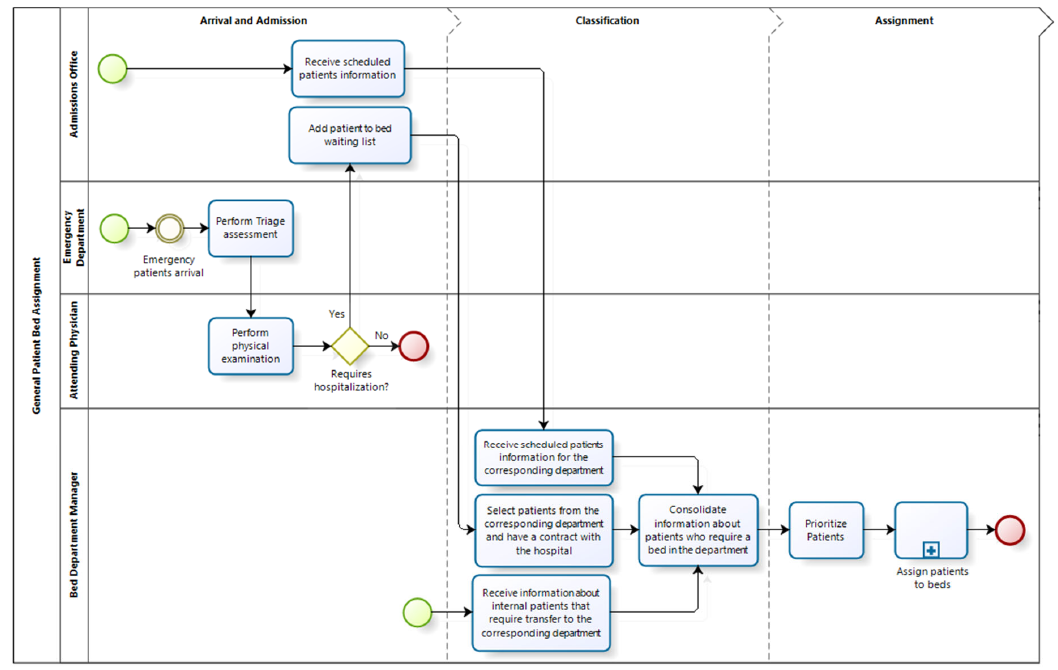
Fig. 1. General patient bed assignment process